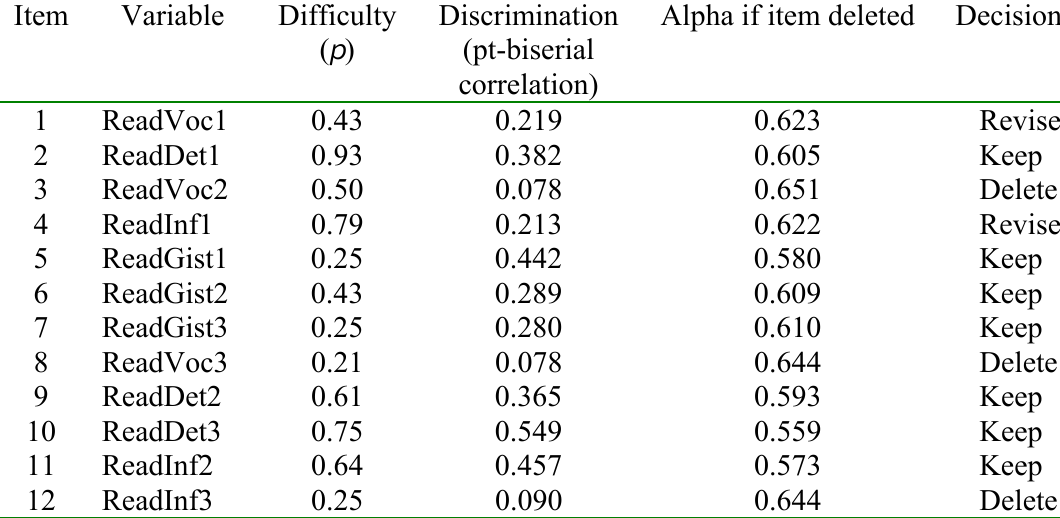
Item Analyses for the Reading Test ( N